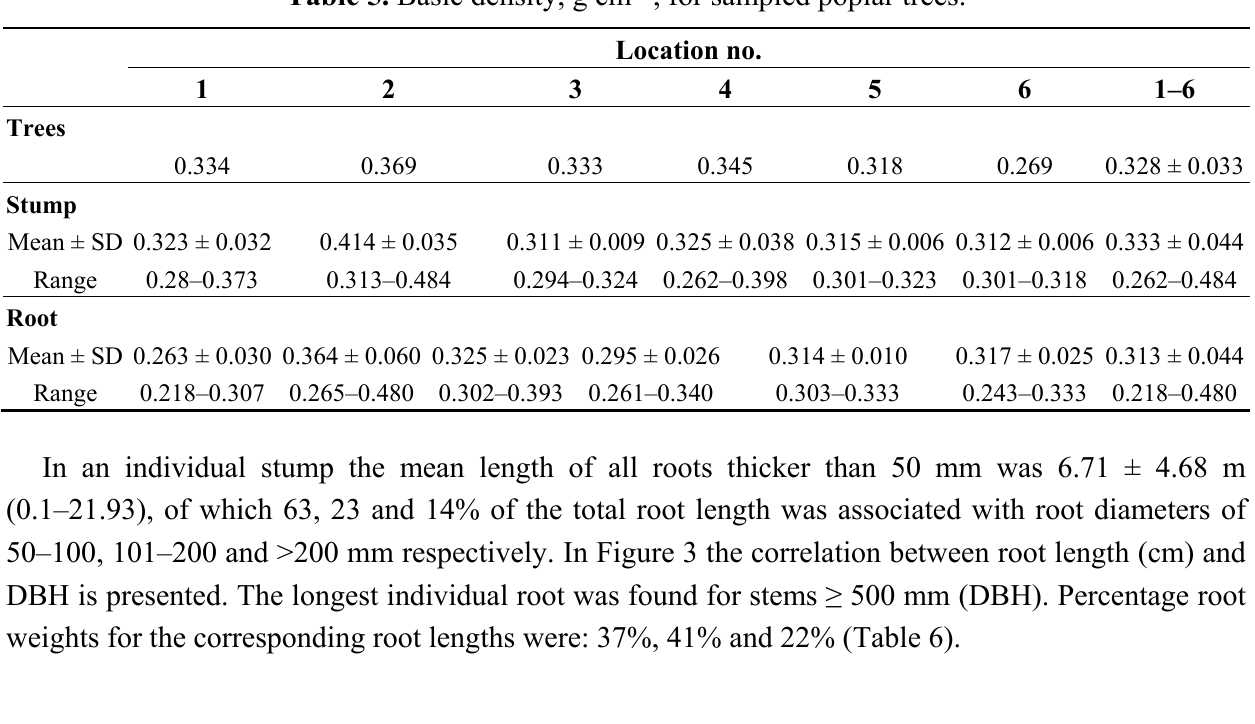
Table 5. Basic density, g cm − 3 , for sampled poplar